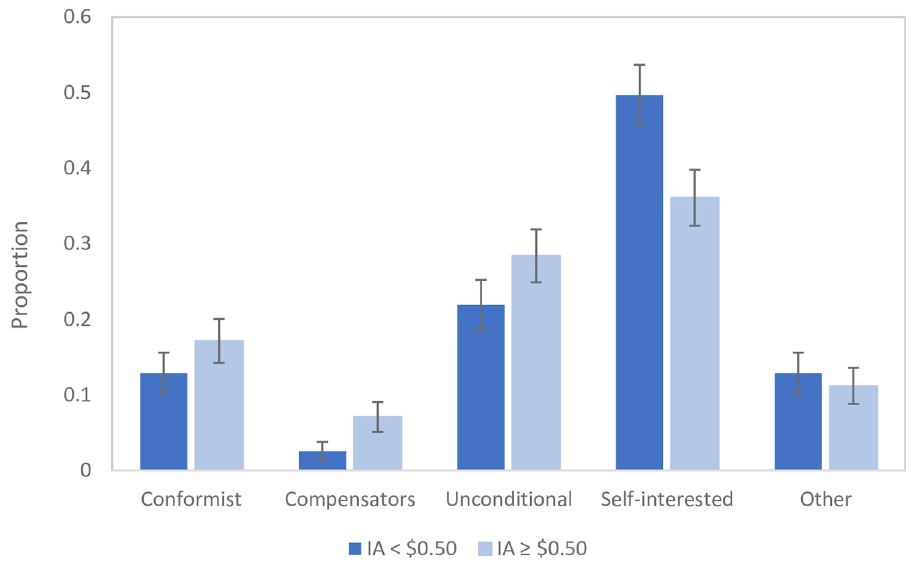
Fig 4. Distribution of SM types by ‘high’ or ‘low’